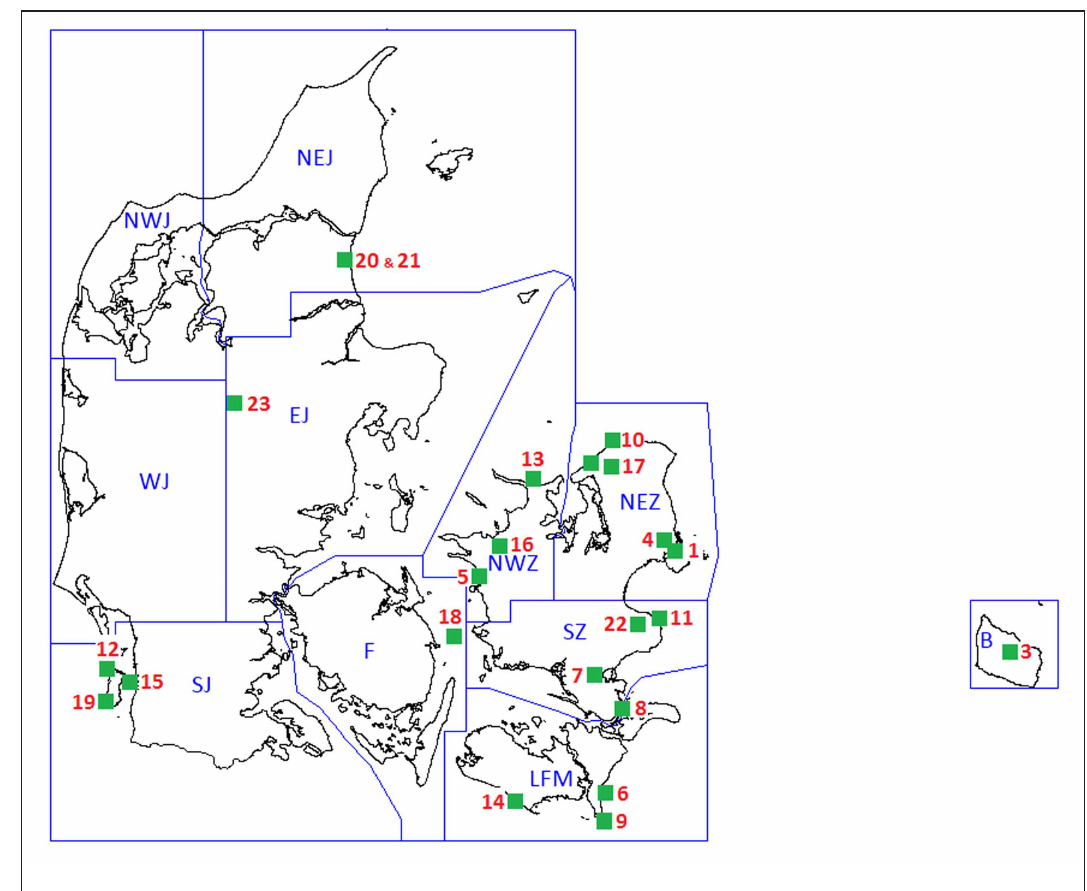
Fig. 96. Location of habitat pictures. 1 . Amager Fælled (Fig. 97A). 2 . Asserbo Plantage (Fig. 97B). 3 . Bastemose (Fig. 97C). 4 . Nordøst for Bispebjerg Station (Fig. 97D). 5 . Bjerge Sydstrand (Fig. 97E). 6 . Bøtø Plantage (Fig. 98A). 7 . Bårse (Fig. 98B). 8 . Gammel Kalvehave (Fig. 98C). 9 . Gedser